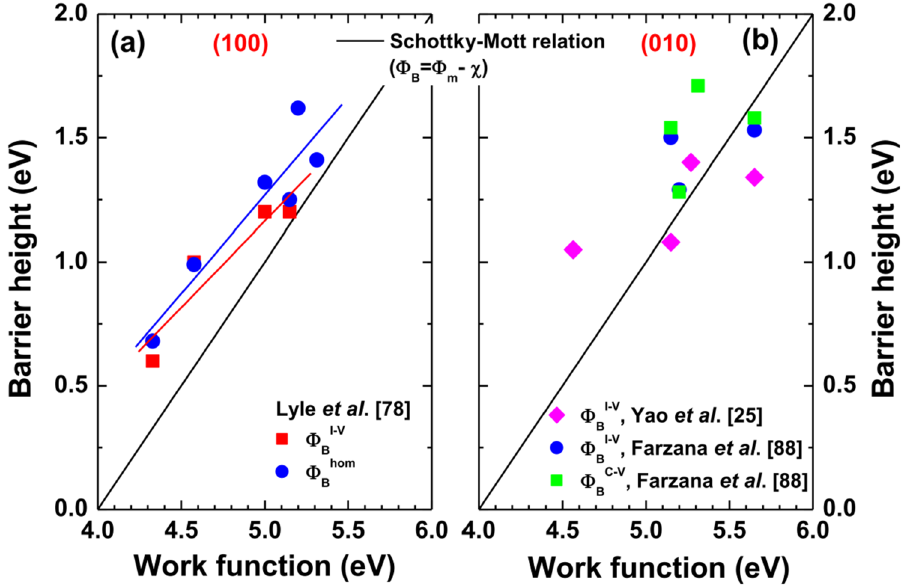
a Carrier concentration for the layer on which the Schottky contacts are formed, b Growth methods: Czochralski (CZ), Edge-defined film-fed growth (EFG), Vertical gradient freeze (VGF), Floating zone (FZ), Low pressure chemical vapor deposition (LPCVD), Metal organic chemical vapor deposition Fig. 4 Plots of barrier height versus metal work function for a (100) β -Ga O Schottky con- 2 3 tacts using the barrier heights taken from Lyle et al. [78] and b (010) β -Ga O Schottky con- 2 3 tacts using the barrier heights taken from Yao et al. [25] and Farzana et al. [88]. The metal work functions were taken from ref.